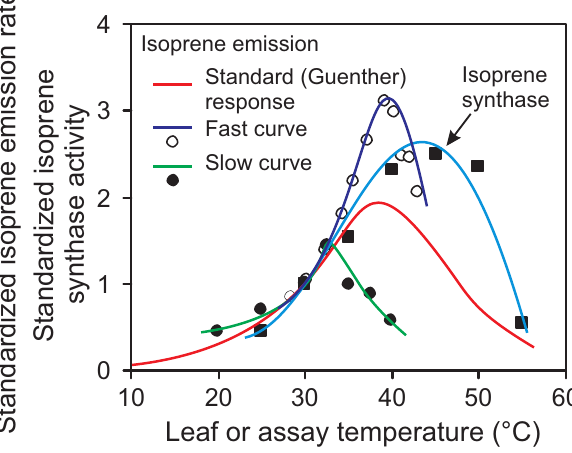
Fig. 2. Comparison of the temperature responses of isoprene syn- thase activity in Populus tremuloides (data from Monson et al., 1992), the “standard” isoprene emission curve by Guenther et al. (1993) model as re-parameterized (1997, Eq. 4) to yield a value of 1.0 at 30 ◦ C, and the measurements of isoprene emission rate in Quercus rubra (data from Singsaas et al., 1999). These measure- ments were either conducted rapidly (4min at each leaf tempera- ture, fast curve) or slowly (30min at each temperature, slow curve). In all cases, the data were standardized with respect to the mea- surements at 30 ◦ C, yielding the temperature response function of isoprene